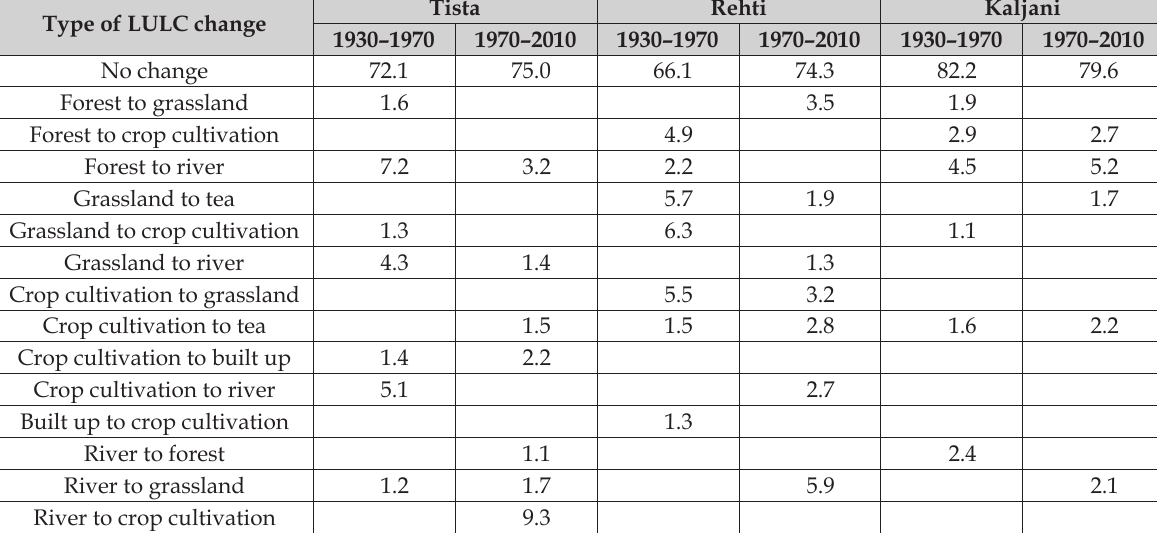
Fig. 5. Percentage contribution of LULC categories in the selected study sites. Table 2. Predominant types of LULC changes (claiming over 1% of the total